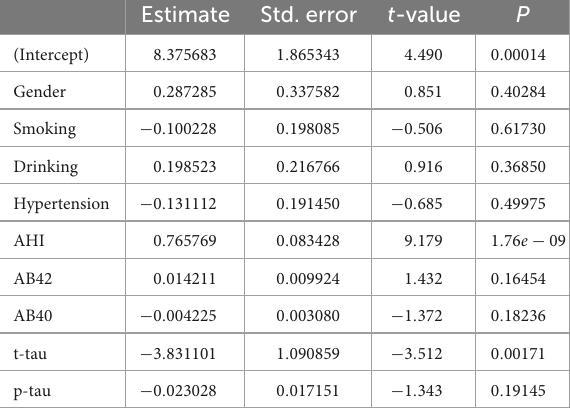
TABLE 4 The stepwise regression results after adding covariates.